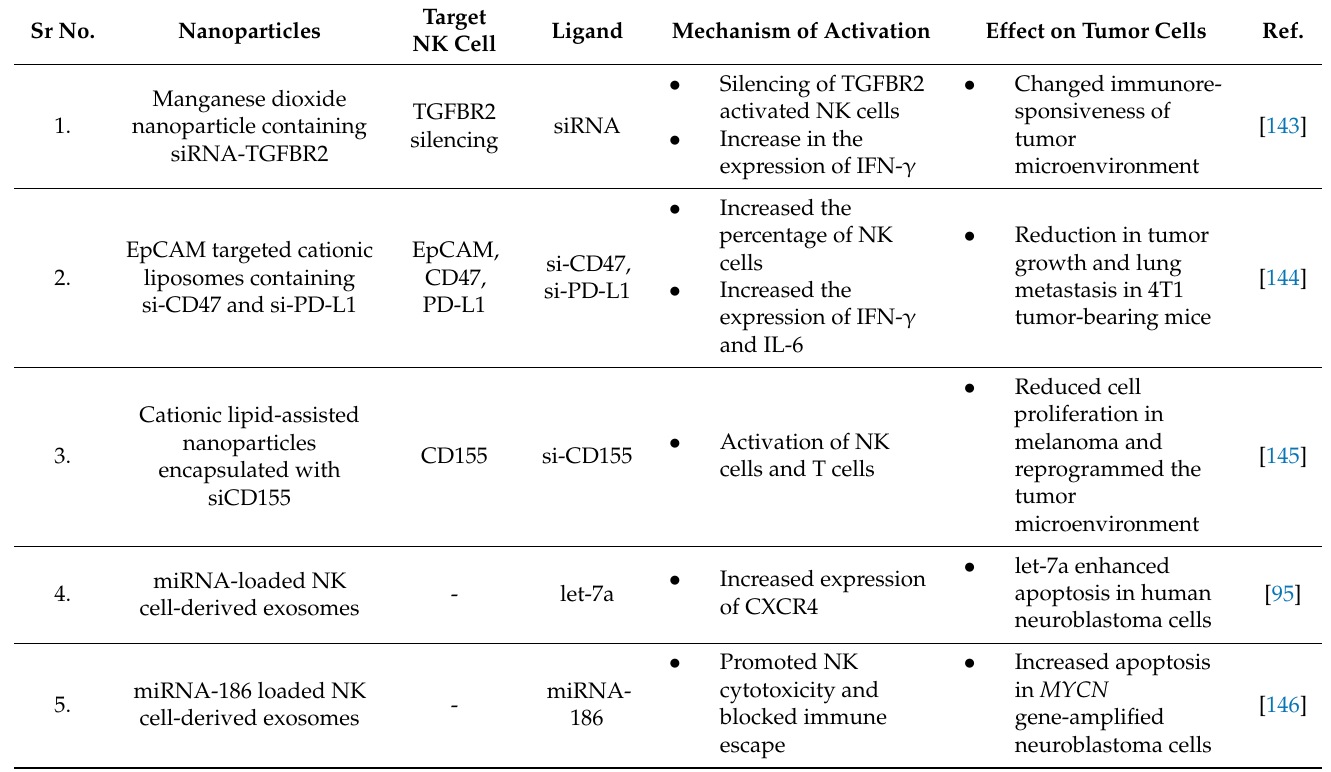
Table 4. Comprehensive information on nanoparticle-based post-translational gene silencing for activation of NK